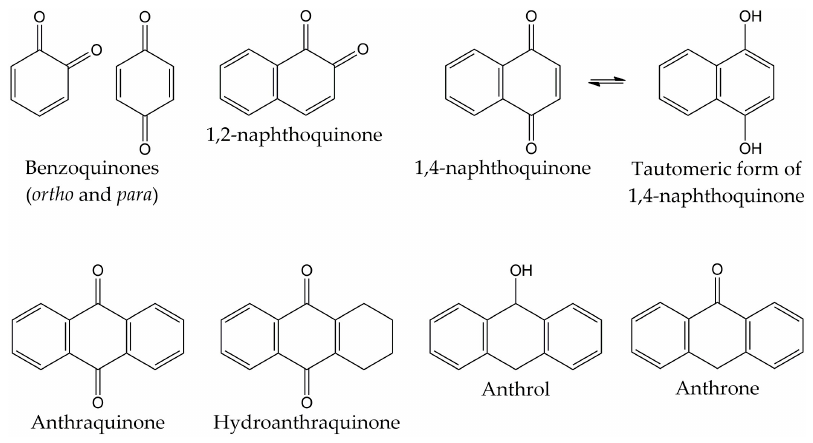
Figure 2. Chemical structures of the different types of